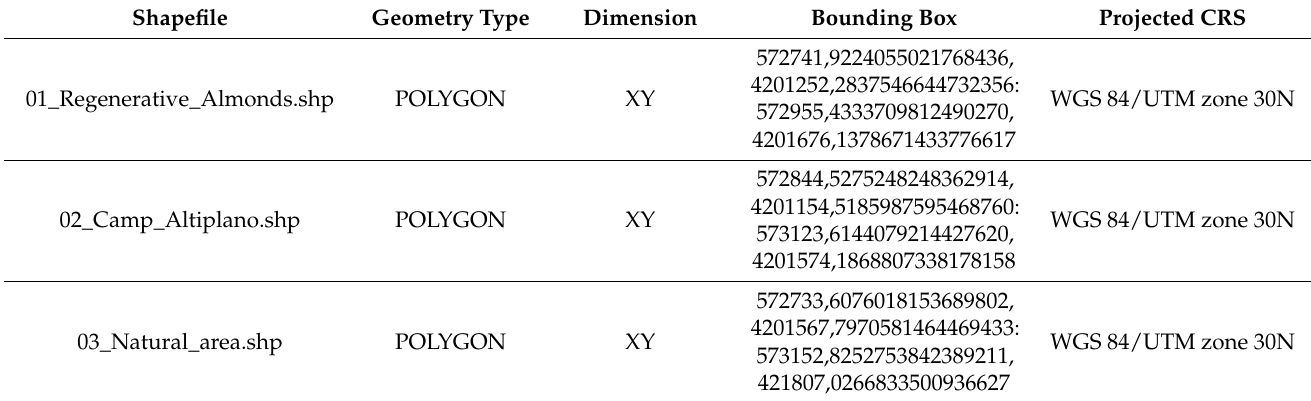
Table 5. Shapefile: 01_Regenerative_Almonds; 02_Camp_Altiplano; 03_Natural_area.